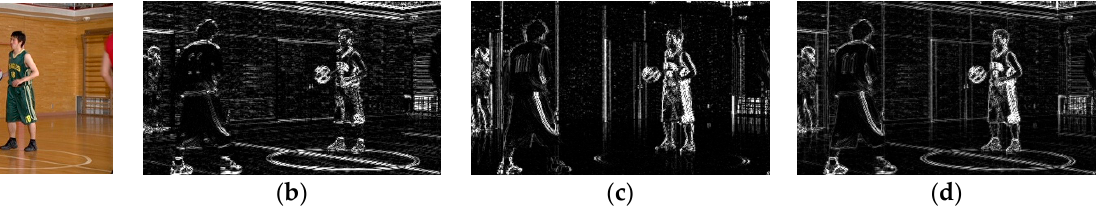
Figure 2. Sample-wise gradients and activity frames of the original image: ( a ) Original; ( b ) Vertical gradient, g v ; ( c ) Horizontal gradient, g h ; ( d ) Activity, A .